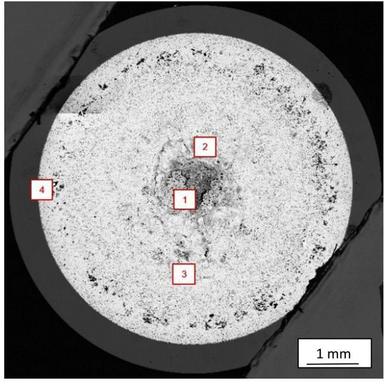
Back-scatter electron imaging of X501-G591 sample cross section from showing also the different regions discussed in the text and described more in details in e